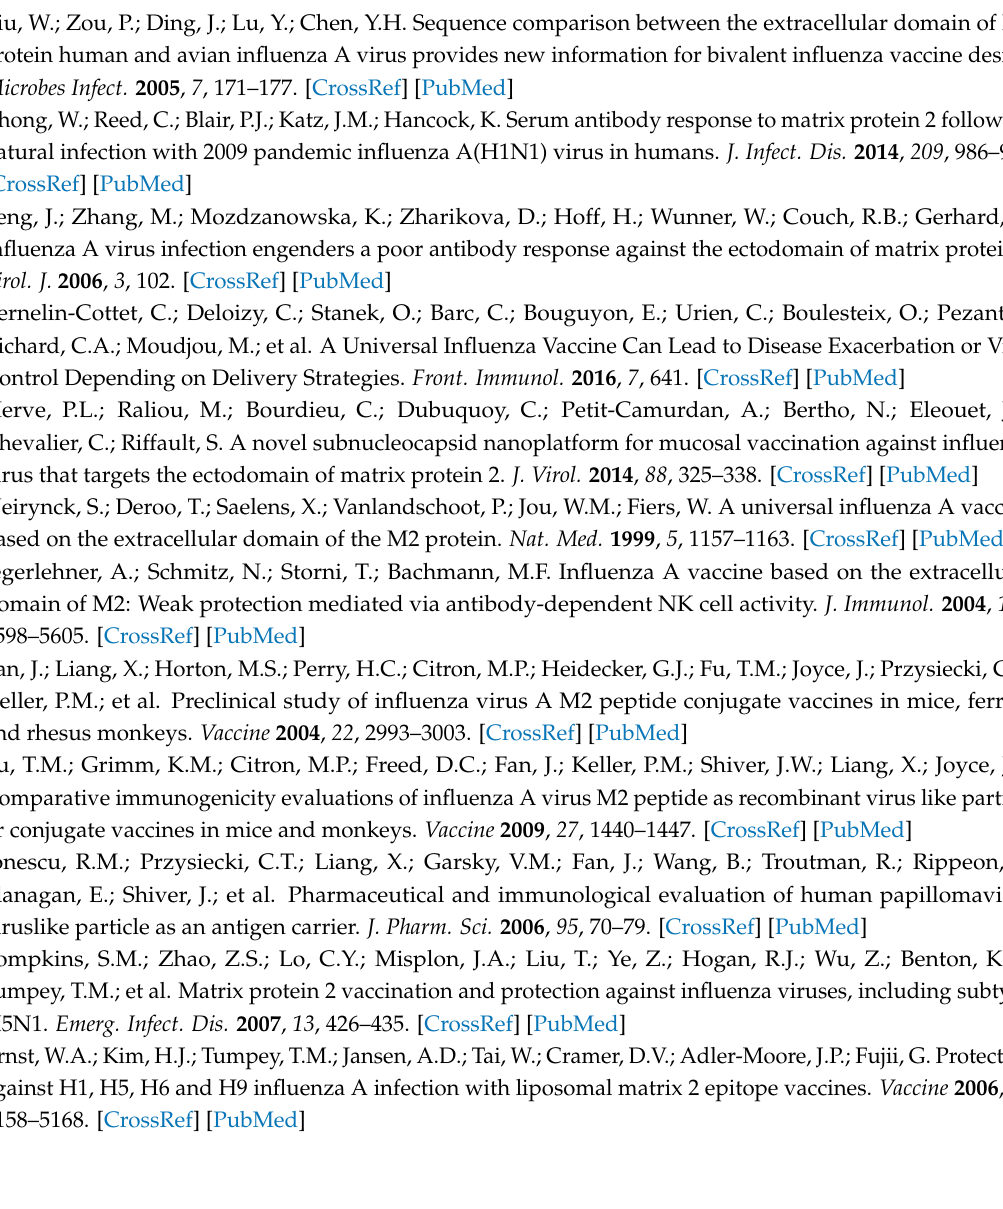
Supplementary Figure 3. Protective effects by M1 VLP immunization. M1 VLP immunized mice (n=8 per Figure A3. Protective effets by M1 VLP immunization. V1 VLP immunized mice (n = 8 per group) group) were infected with a lethal dose of A/Philippines/2/1982 (H3N2) at 6 weeks after boost immunization. (a) were infected with a lethal dose of A/Philippines/2/1982(H3N2) at 6 weeks after boost immunization. Body weight changes. (b) Lung viral titers were detected by inoculating chicken eggs. EID 50 , 50% egg infections ( a ) Body weight changes. ( b ) Lung viral titers were detected by inoculating chicken eggs. EID 50 dose. (c) The spot numbers of IFN-γ in the lungs. Lung cells collected at 6 dpi were stimulated with 4 µg/ml 50% egg infections dose. ( c ) The spot number of IFN- γ secreting cells were determined by ELIASpot. inactivated H3N2 (iH3N2) virus for 48 h. IFN-γ secreting cells were determined by ELISpot. The statistical significance was confirmedby one-way ANOVA and Dunnett’s multiple comparison test. Error bars indicate the The statistical significance was confirmed by one-way ANOVA and Dunnett’s multiple comparison means ± SEMof pooledsamples fromeachgroupofanimals.***; p <0.001. text. Error bars indicate the means ± SEM of pooled samples from each group of animals.***: p <